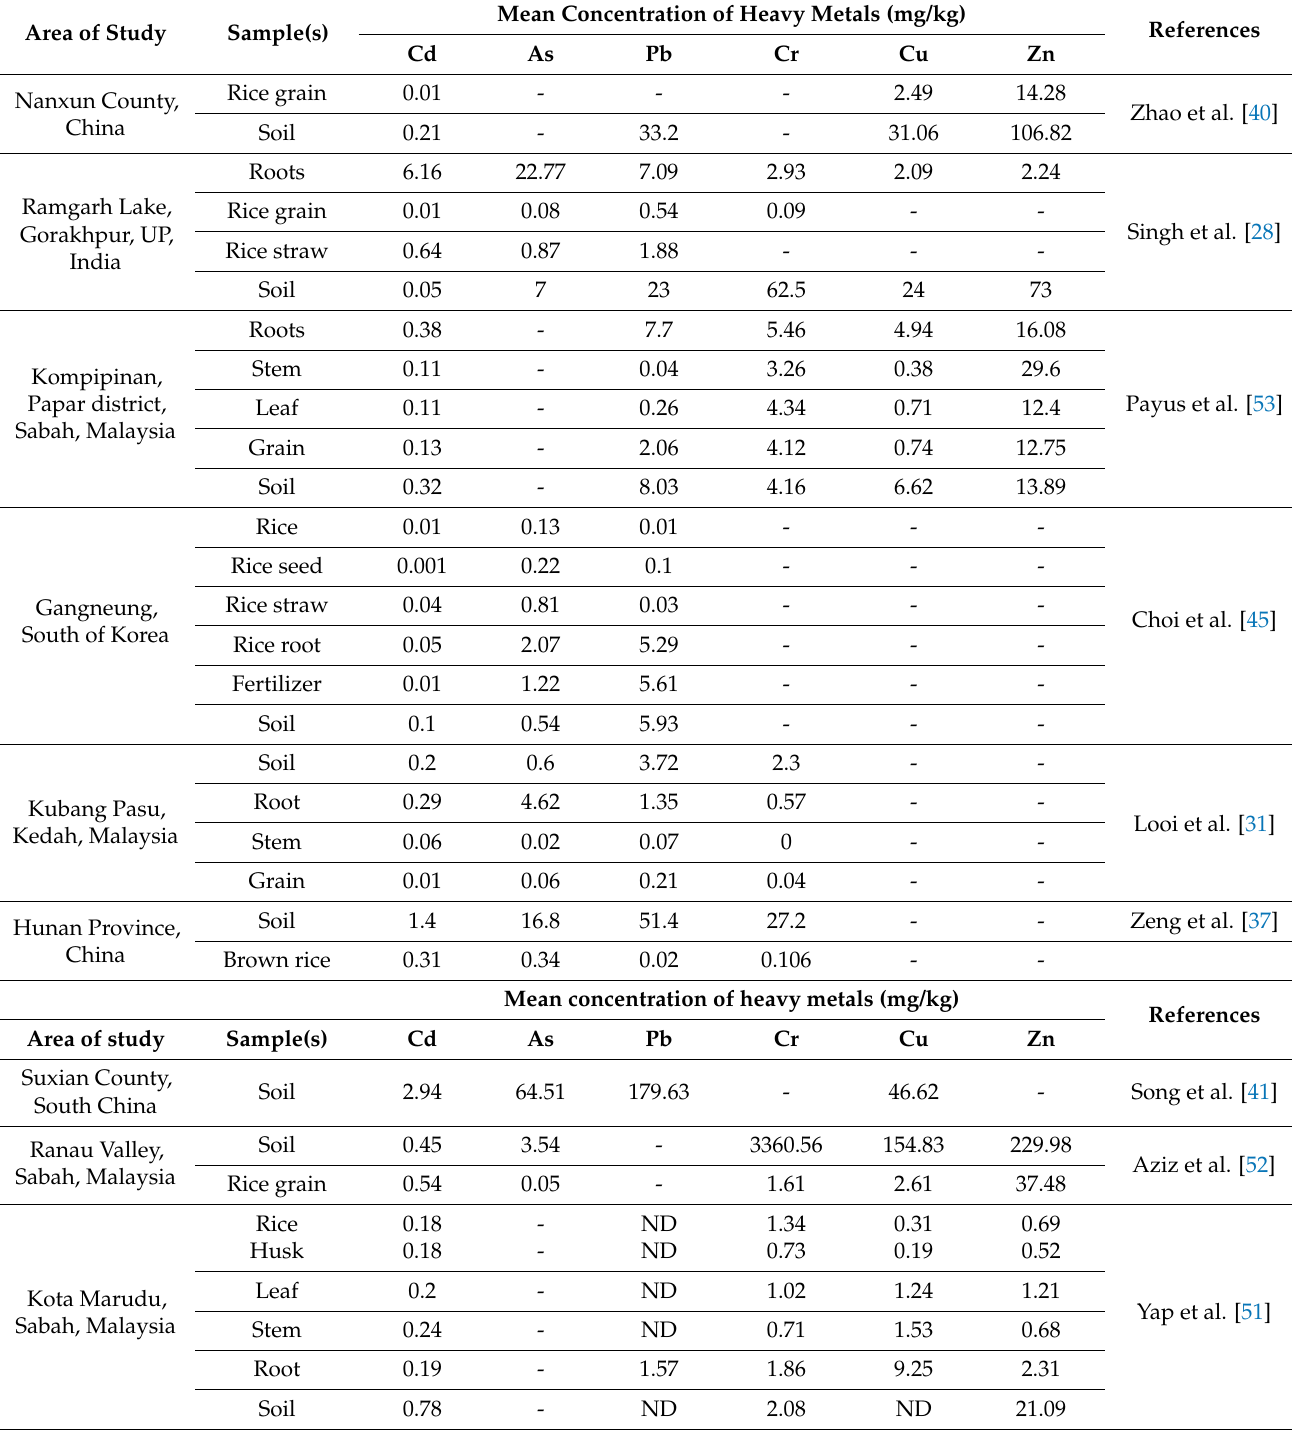
Table 1. Summary of heavy metals concentration in paddy plants and soil in selected areas of different countries. Area of